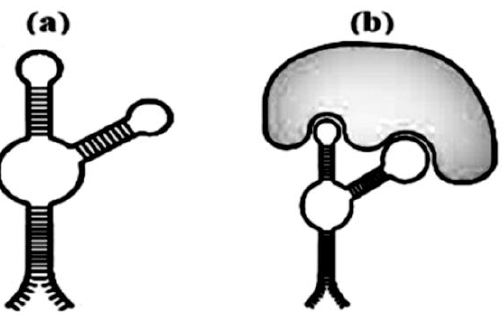
Figure 2. Aptamer secondary structure ( a ) and aptamer with a marker ( b